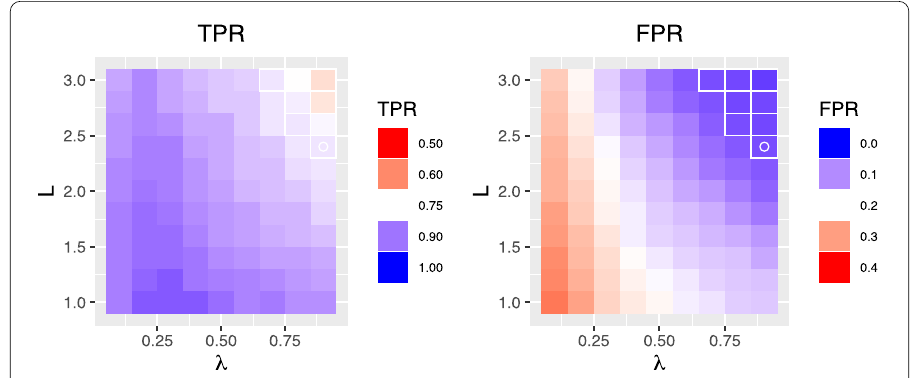
Figure 5 The TPR and FPR for the EWMA. We show the TPR and FPR as a function of λ and L . Here, white boxes represent the parameter values where FPR ≤ 0.05, and the white circle indicates the maximum of TPR among FPR ≤ 0.05